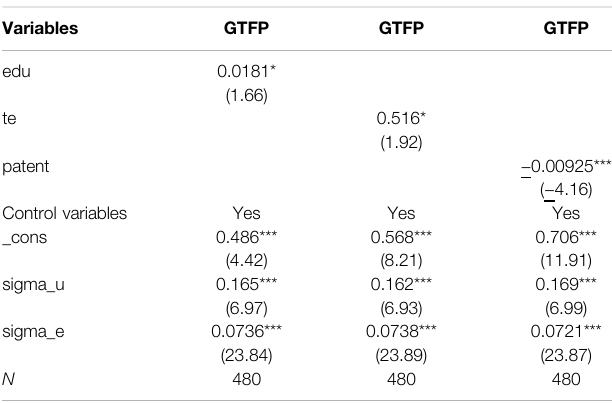
TABLE 12 | Robustness test (removal of extreme